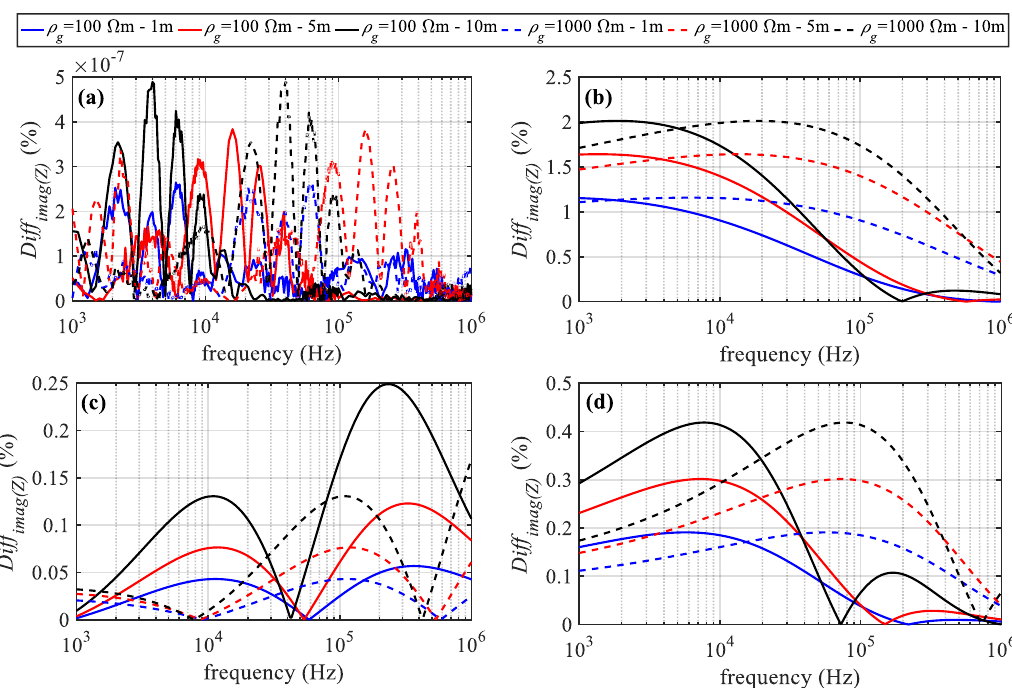
Figure 10. Differences in the imaginary part of Z 13 in NB using the closed-form expression of ( a ) Carson, ( b ) Dubanton ( c ) Noda and ( d ) Alvarado-Betancourt.